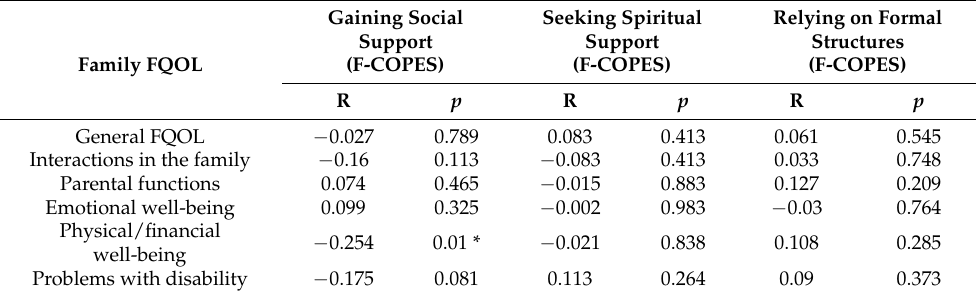
Table 4. Gaining social support and seeking spiritual support (F-COPES) and the level of FQOL in the assessment of children and adolescents with SI. Gaining Social Seeking Spiritual Support Support Family FQOL (F-COPES)